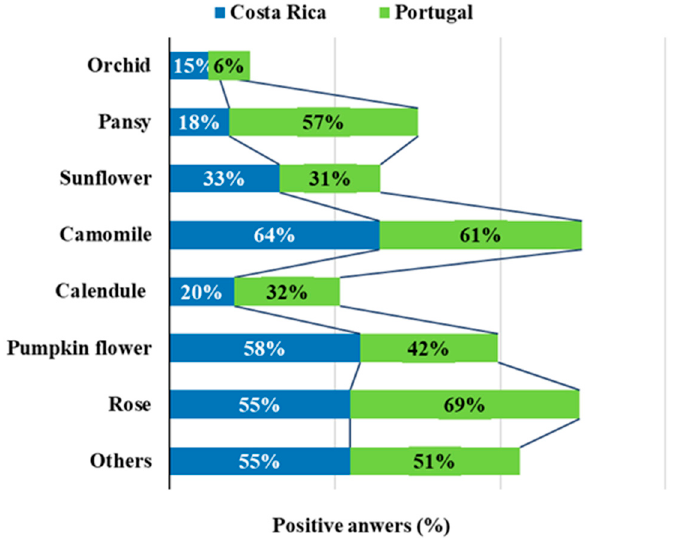
Figure 2. Types of flowers consumed by the participants.